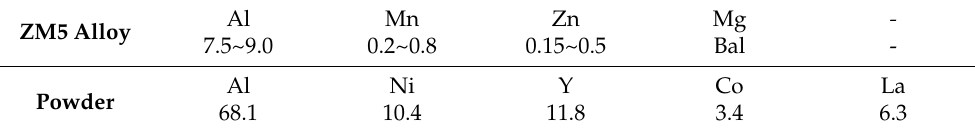
Table 1. Alloy compositions (wt.%) of the ZM5 Mg substrate and amorphous